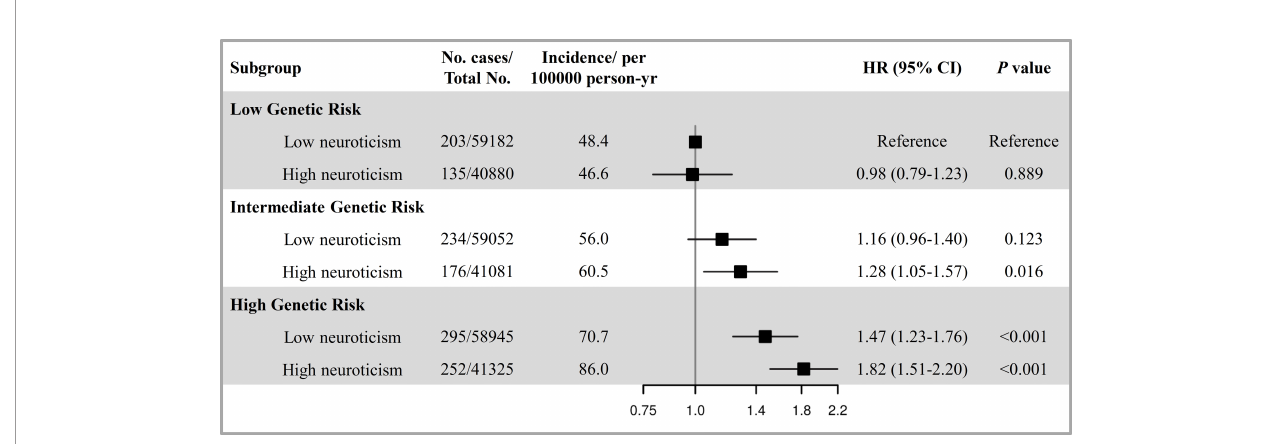
FIGURE 2 | The joint effect and additive interaction of neuroticism and genetic risk with the risk of incident lung cancer. The genetic risk was categorized into low (lowest tertile), intermediate (second tertile), and high (highest tertile). The neuroticism was de fi ned as low and high according to median level. HRs and 95% CIs were estimated using Cox proportional-hazard models with adjustment for age at recruitment, sex, ethnic background, education, family history of lung cancer, smoking status, alcohol intake frequency, BMI, physical activity, the fi rst ten principal components of ancestry and genotyping